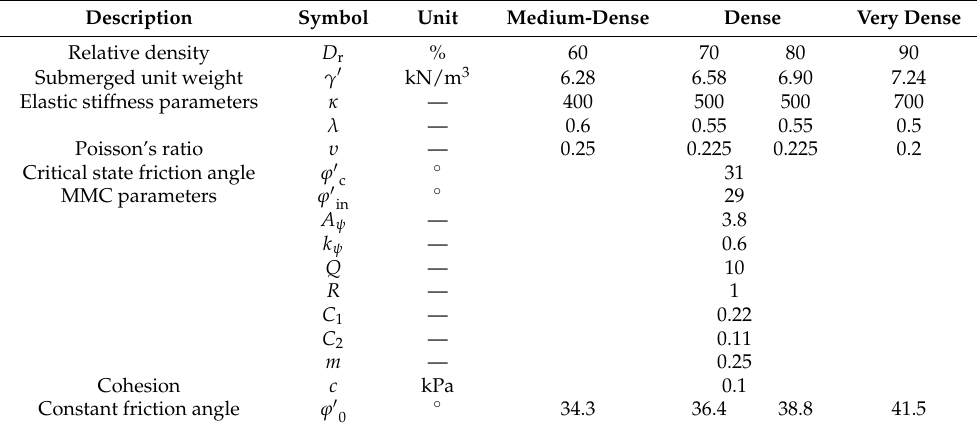
Table 1. Properties of sand used in FE analyses [31,32].